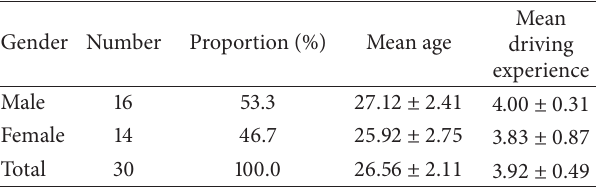
Table 1: Analysis of the participants’ basic